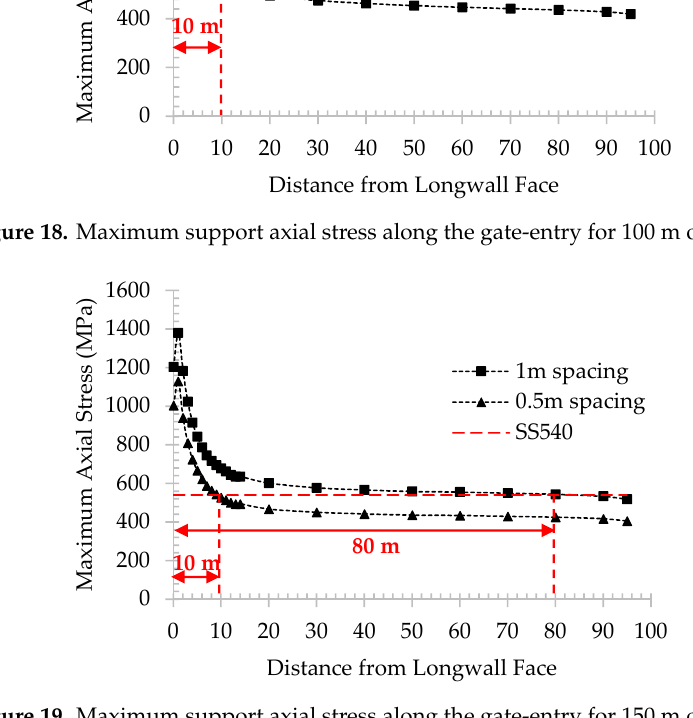
Figure 19. Maximum support axial stress along the gate-entry for 150 m of depth.